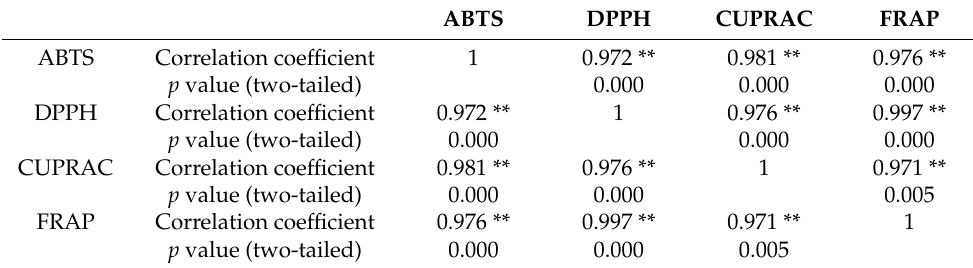
Table 3. Correlation between the different methods applied for testing antioxidant activity in this research.